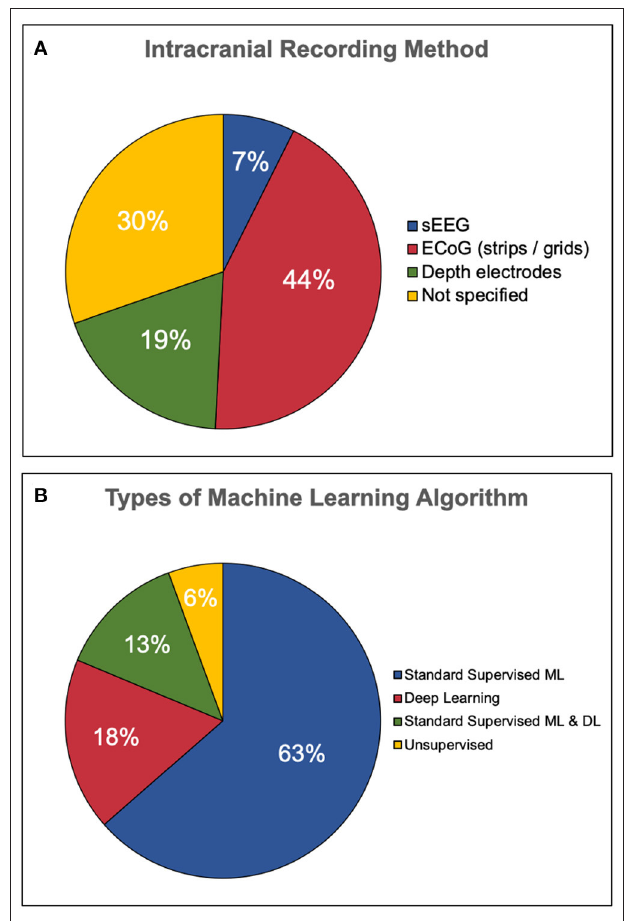
FIGURE 4 | Types of iEEG recording and classification algorithm employed. (A) Less than half of the publications employed electrocorticography techniques such as strips and grids. The second most popular recording method was depth electrodes followed by a minority of stereotactic EEG. One third of the articles did not specify the type of recording method. (B) The majority of studies employ standard supervised machine learning (ML) only, while only 18% used deep learning (DL) only. Thirteen percent used both standard and deep learning while a minority used unsupervised